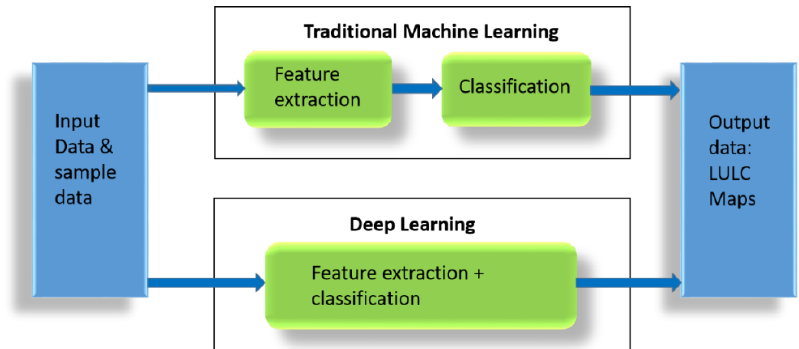
Figure 7. A simple artificial neural network.